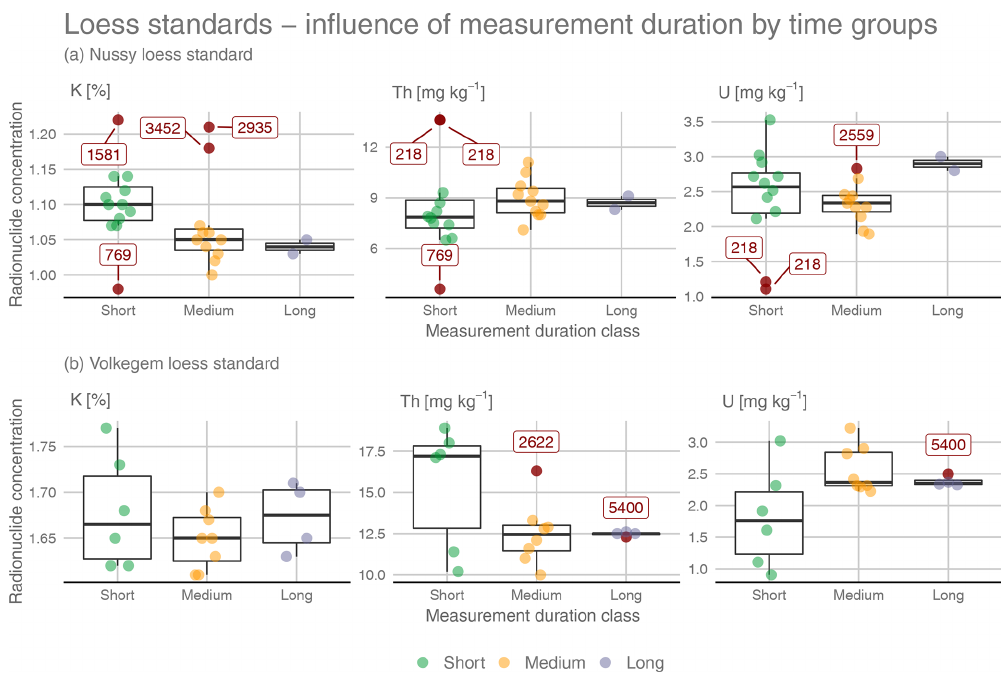
Figure 7. Radionuclide concentrations determined by µ Dose measurements given as percent for K (left) and as milligrams per kilogram (mgkg − 1 ) for Th (centre) and U (right). Results of individual measurements and box plots for the loess standards Nussy (a) and Volkegem (b) . Data grouped by measurement duration into three classes: short-time ( < 2000 α counts; green symbols); medium-time (2000–4000 α counts; yellow symbols); long-time ( > 4000 α counts; grey symbols). Outliers (red symbols) as identified by the 1.5 IQR criterion and labelled with their respective numbers of total α counts. Classification is not based on specific statistical arguments but reflects the realization of the